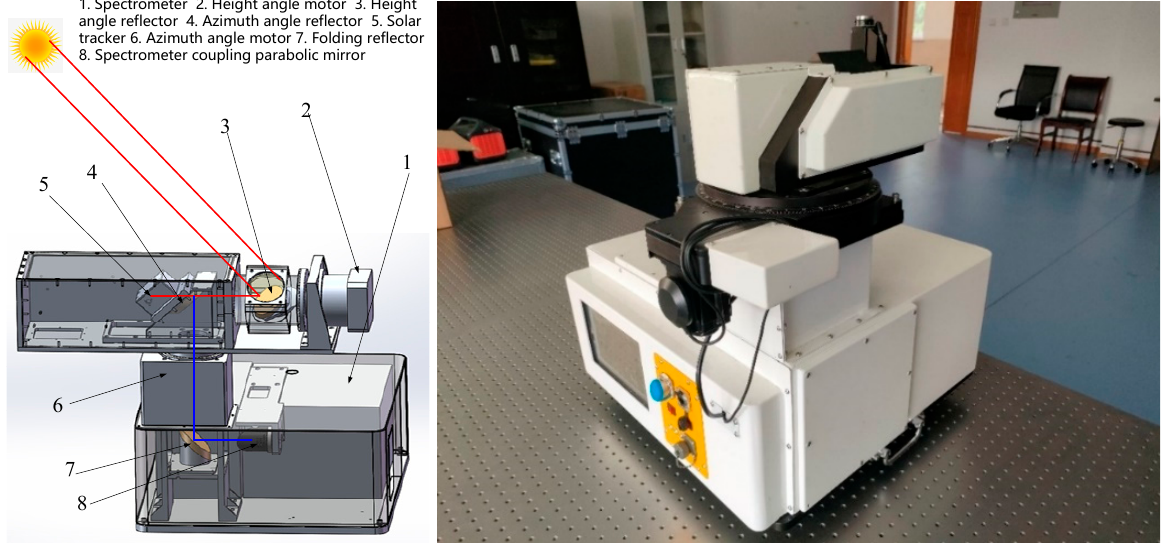
Figure 5. The three-dimensional model diagram of HRFTS structure ( left figure) and real object ( right figure).